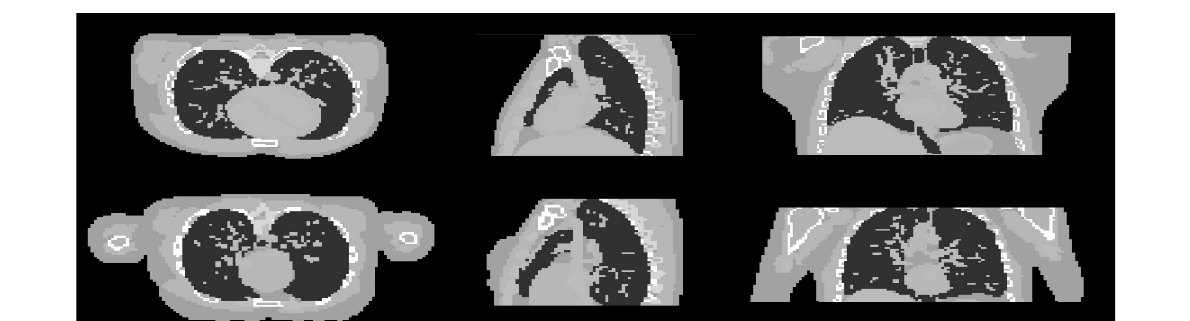
Figure 10. Cross sectional slices of the male ( top row ) and female ( bottom row ) phantoms in the three axes.